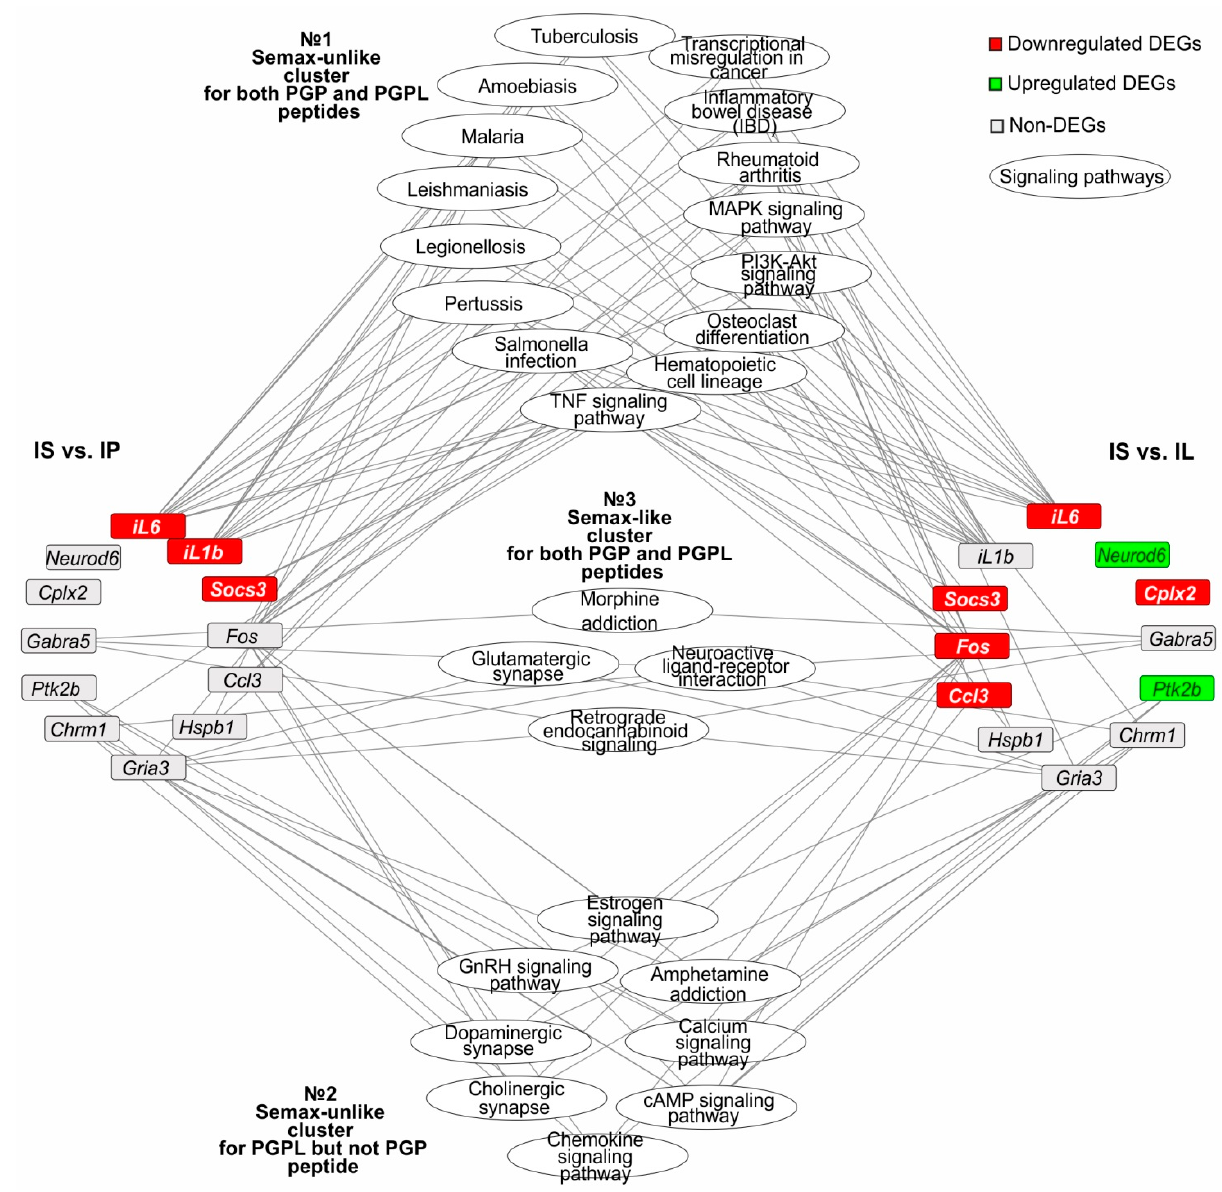
Figure 4. A regulatory network that reflects common and unique gene expression effects of PGP, PGPL, and Semax peptides in IR conditions. The network was constructed using Cytoscape 3.8.2 (Institute for Systems Biology, Seattle, WA, USA). The oval blocks at the nodes represent signaling pathways. The gray, green, and red rectangular boxes represent non-, up- and downregulated genes, respectively. The lines connecting the oval and rectangular blocks indicate the participation of the protein products of genes in the signaling pathway.